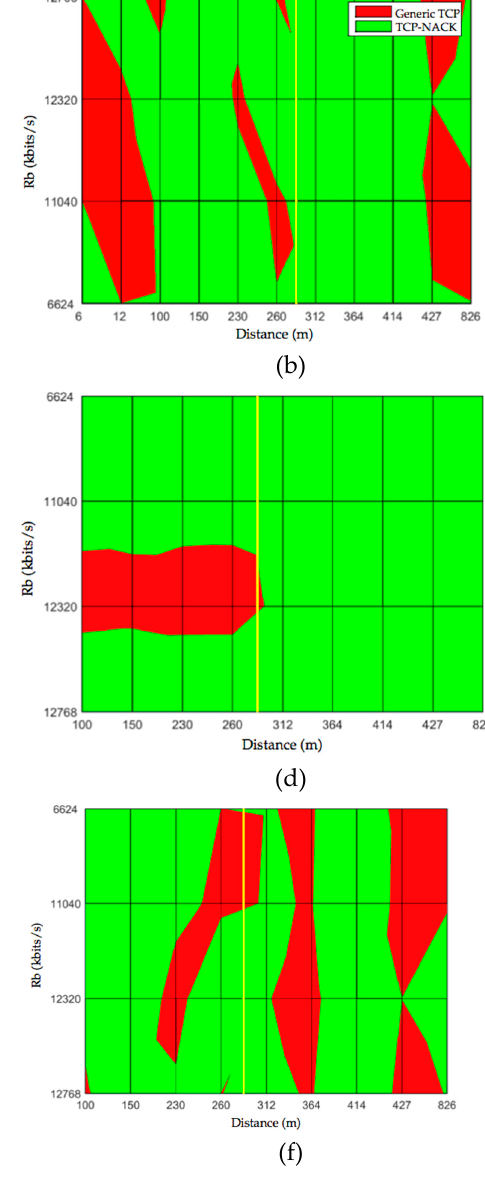
Figure 11. Short-medium distance results: ( a ) θ ; ( b ) upper θ ; ( c ) δ ; ( d ) bottom δ ; ( e ) jitter; ( f ) bottom jitter.